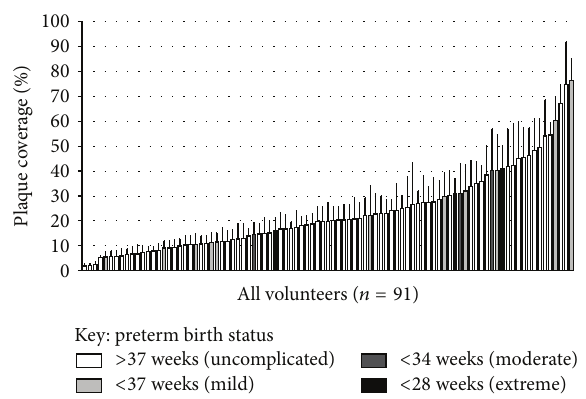
Figure 3: Ranked distribution of mean percentage plaque coverage for all volunteers highlighting those who gave birth preterm. Error bars show 95% confidence intervals for the measured teeth ( 𝑛 = 10– 12).